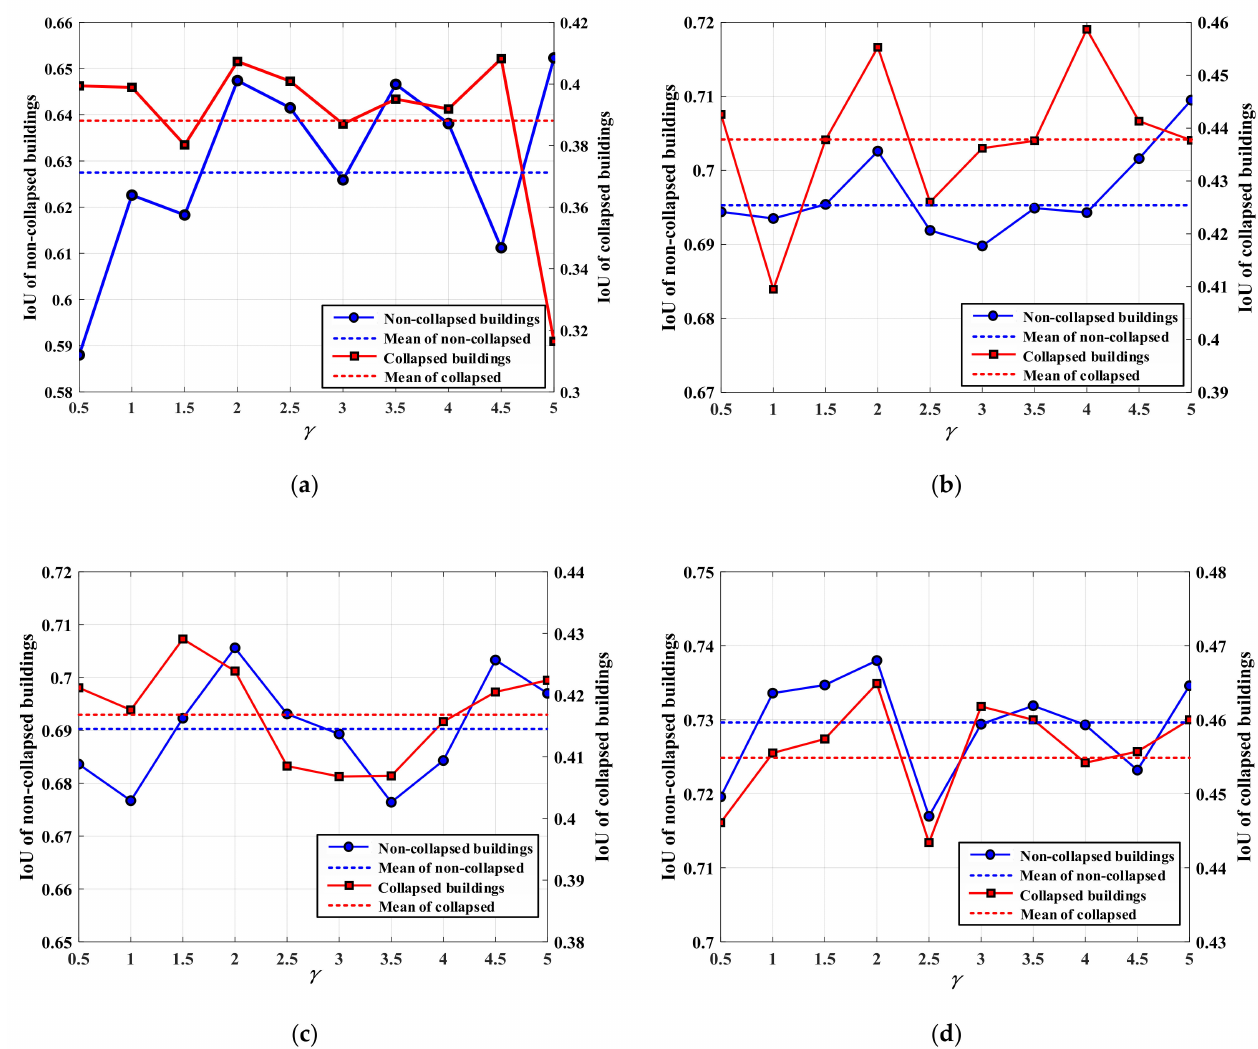
Figure 16. The influence of the setting of γ on the IoU corresponding to collapsed and non-collapsed buildings. ( a ) OB- DeepLabv3+ on the YSH dataset. ( b ) OB-UNet on the YSH dataset. ( c ) OB-DeepLabv3+ on the HTI dataset. ( d ) OB-UNet on the HTI